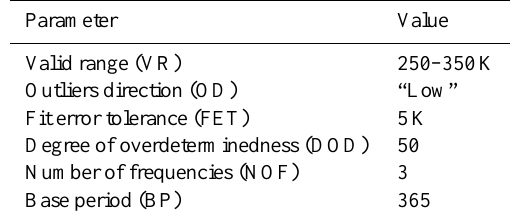
Table 2. HANTS parameter settings used in this